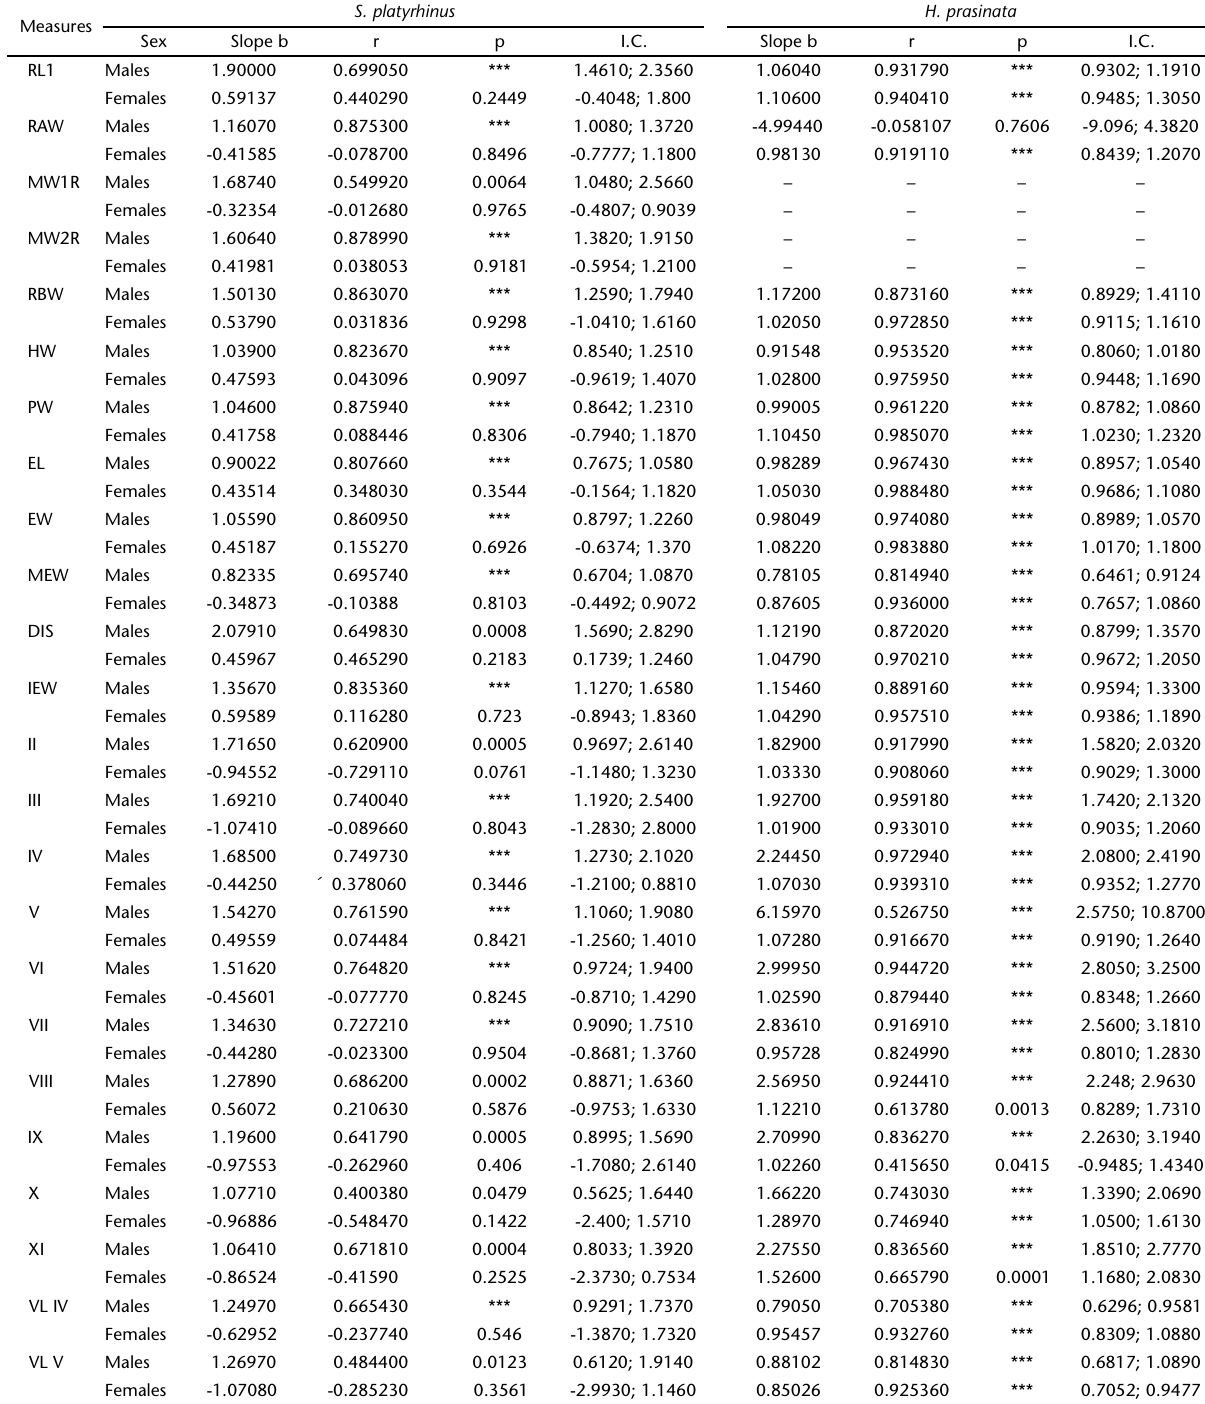
Table IV. Reduced Major Axis regression (RMA) results between pairs of morphological variables selected with positive allometry in S. platyrhinus and H. prasinata . Prothorax length (PL) was used as a predictor variable. All variables were log-transformed prior to males and females. (***) for p (cid:2)